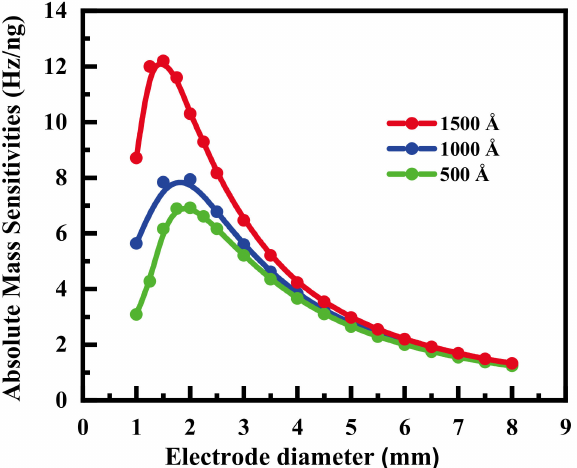
Figure 8. Theoretical absolute mass sensitivity distribution of AT-cut 10 MHz QCM with different electrode diameters and electrode thicknesses